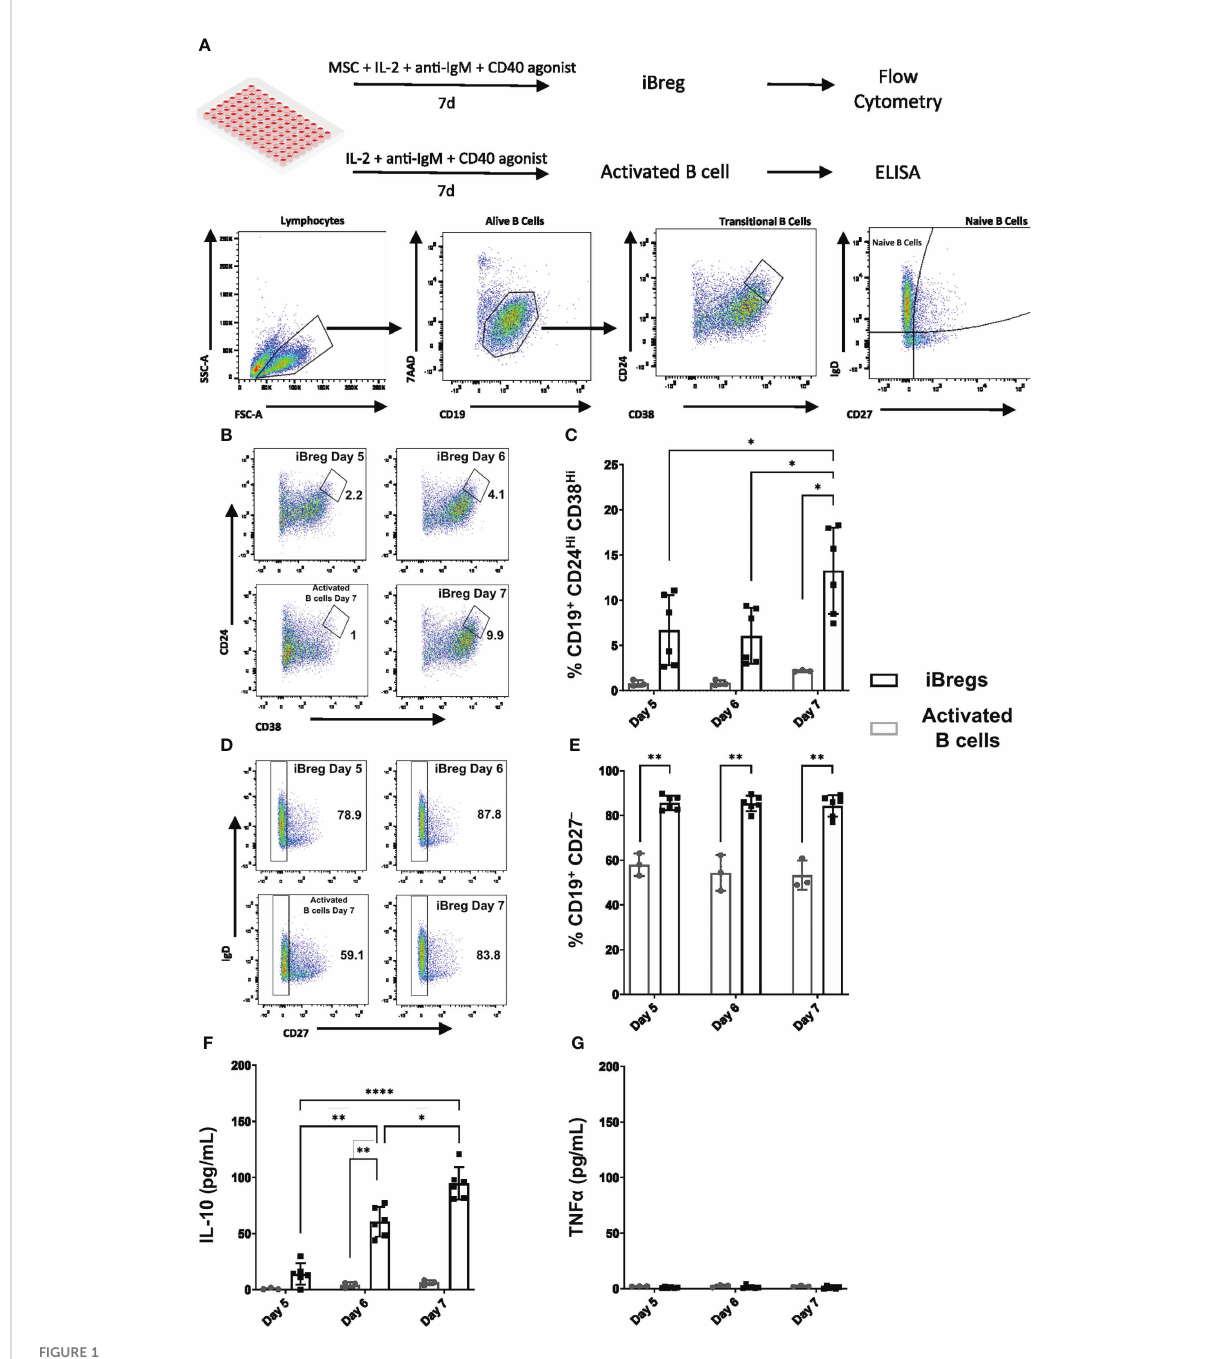
FIGURE 1 MSC induce regulatory B cells enriched in transitional B cell phenotypes and secrete IL-10. (A) Graphical protocol for the generation of in vitro induced regulatory B cells (iBreg) and activated B cells and downstream analysis including gating strategy of fl ow cytometry samples. (B) Representative FACS plots showing the percentage of Transitional B (CD19 + CD24 Hi CD38 Hi ) cells from alive B cells (CD19 + 7AAD - ). (C) Summarized data for the frequency of Transitional B cells, showing a signi fi cant increase at day 7 (D) Representative FACS plots showing the percentage of naïve B cells (CD19 + CD27 - ) from alive B cells (CD19 + 7AAD - ). (E) Summarized data for the frequency of Naïve B cells showing a signi fi cant increase in the presence of MSC. (F) Supernatant cytokine quanti fi cation by ELISA of IL-10. IL-10 production increased after day 5, with a peak production observed at day 7. (G) Supernatant cytokine quanti fi cation by ELISA of TNF a . TNF a production was absent in iBreg and activated B cells. Data shows at least three independent experiments in each group. Cells from 2 MSC donors and 3 Tonsil donors were used. Error bars represent SD. Two-way ANOVA was performed to determine statistical signi fi cance. *p < 0.05, **p < 0.01, ****p <